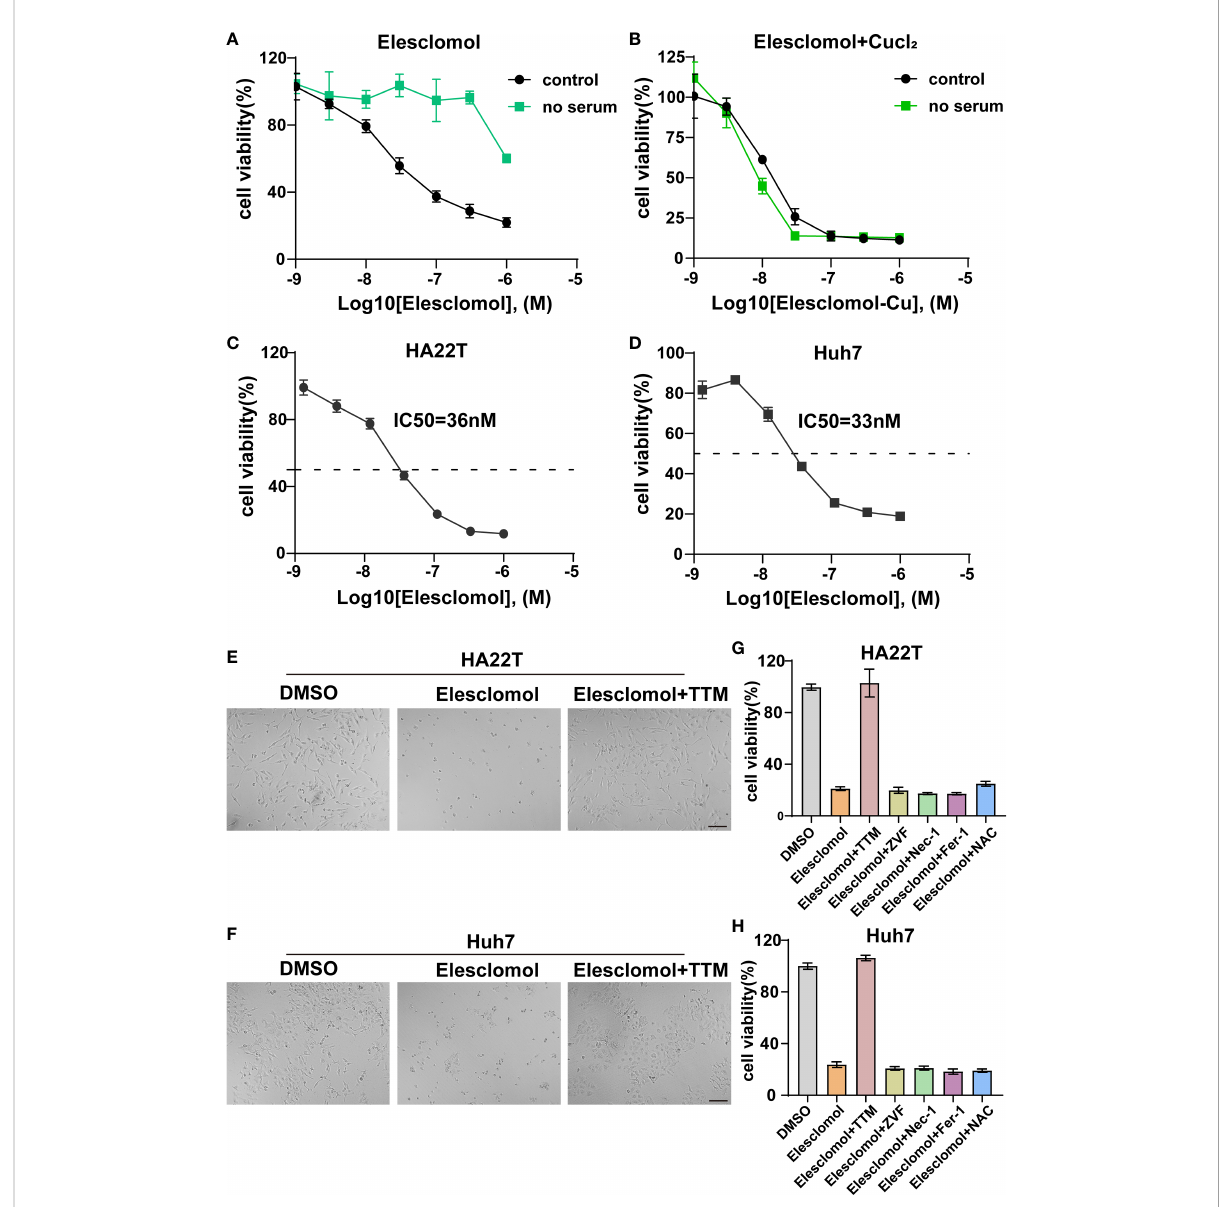
FIGURE 10 Validation of cuproptosis induced by elesclomol. (A) Cell viability of HCC cell when grown in the presence or absence of serum and treated with elesclomol. (B) Cell viability of HCC cell when grown in the presence or absence of serum and treated with either elesclomol or elesclomol in the presence of CuCl2. (C, D) HA22T and Huh7 cells were exposed to different doses of elesclomol for 24h and detected by CCK8 reagent. (E, F) Representative images of HCC cells treated with elesclomol (40nM) with or without TTM (5 m M) for 48h. Scale bars represent 200 m m. (G, H) The rescue effect of cell death inhibitors on elesclomol treatment in HA22T and Huh7 was explored through CCK8 assay. Data was presented as mean+SD. ZVF, Z-VAD-FMK; Fer-1, ferrostatin-1; Nec-1, necrostatin-1; NAC, N-acetyl cysteine; TTM,